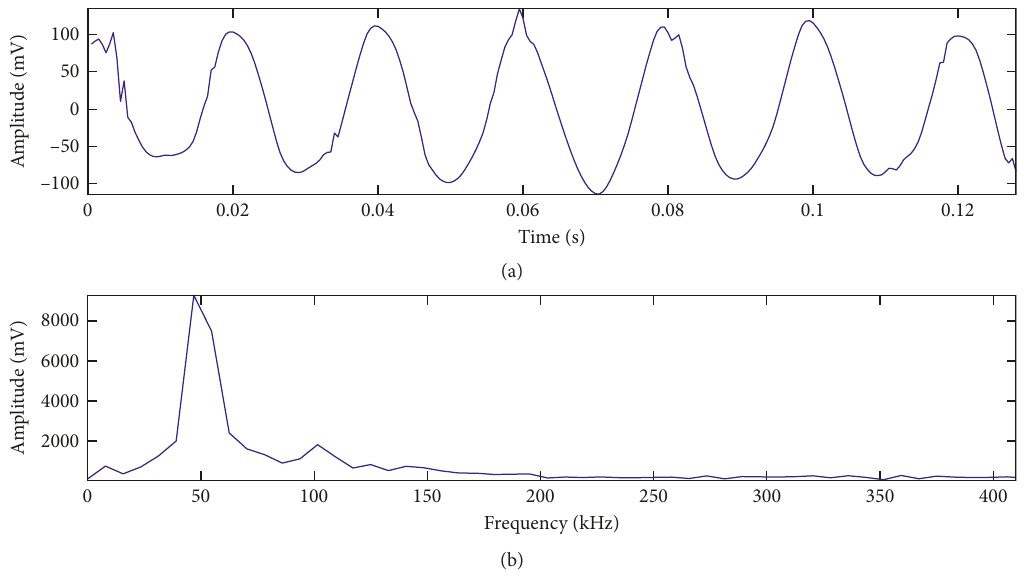
Figure 5: Time-frequency curve after wavelet threshold denoising.